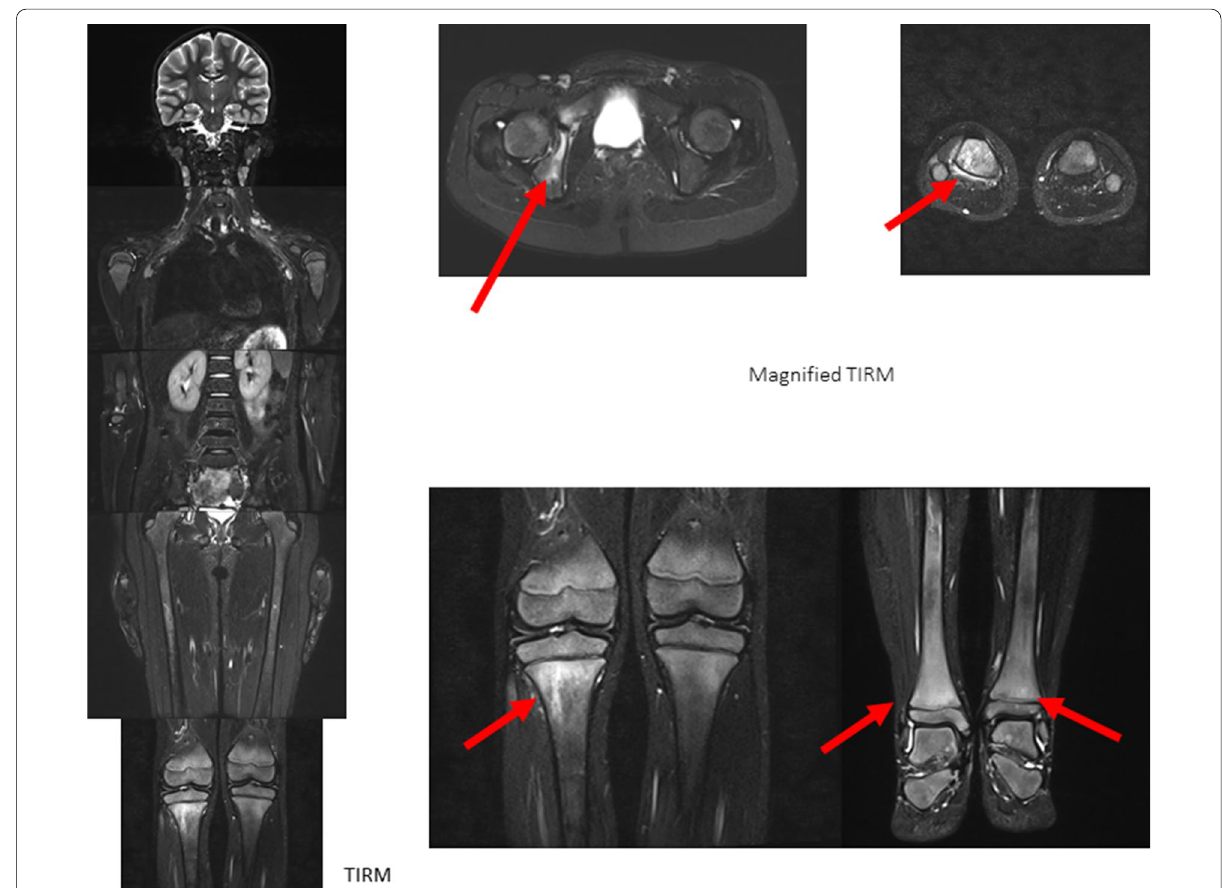
Fig. 2 An 8-year-old girl without previous history of MSK pathologies and pain at multiple body regions (back, lower extremities). MRI shows bone marrow edema, affecting the long bones (with focus on epiphyseal and metaphyseal areas) and pelvis